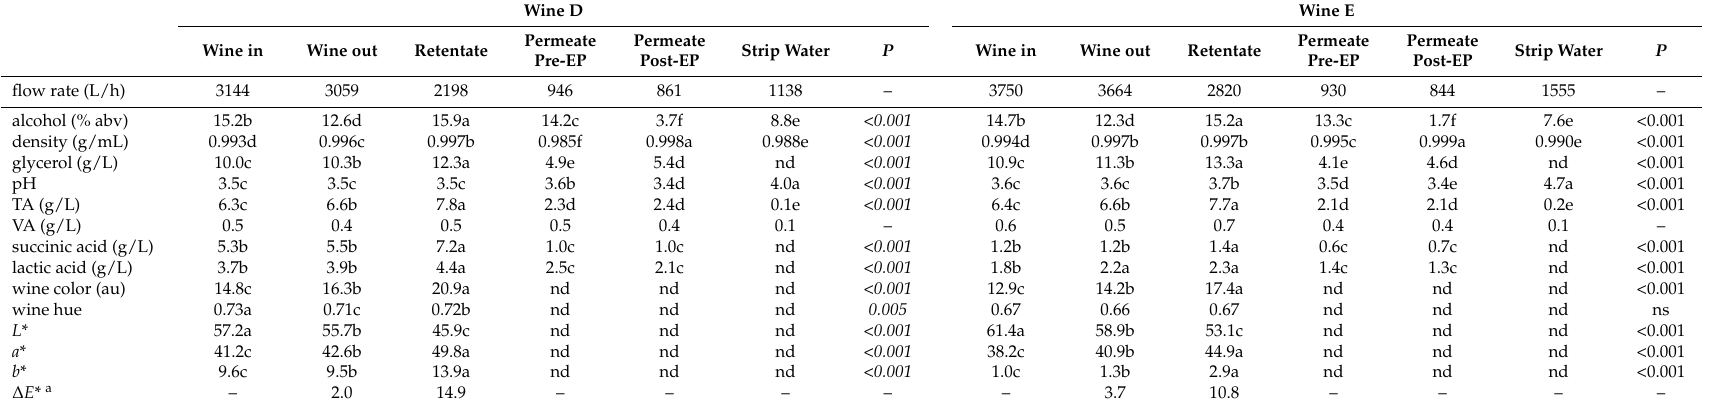
Table 3. Flow rate, density and basic composition of samples collected during RO-EP treatment of Trial 2